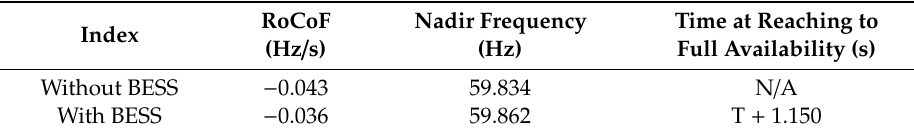
Figure 10. Comparison of result without and with BESS. Table 7. Evaluation result from Figure 10. Table 7. Evaluation result from Figure 10.